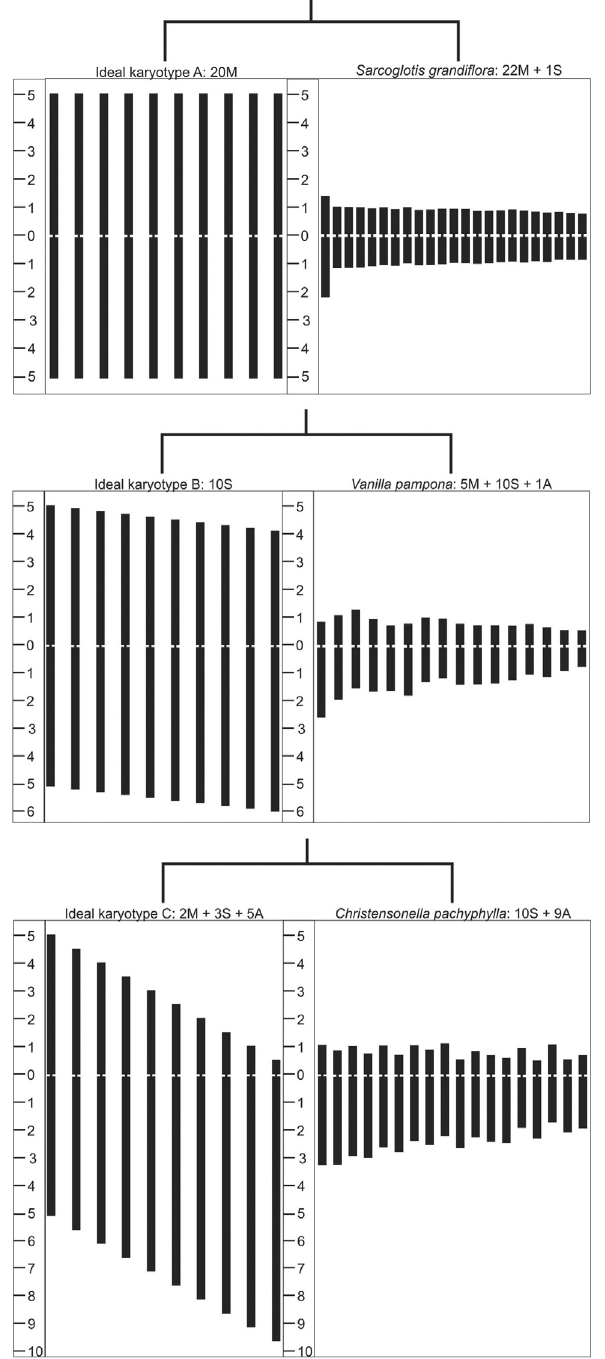
Figure 2 - Ideograms of the ideal karyotypes A, B and C, as well as the most similar species, grouped by UPGMA, equally obtained by the in- dexesAsk%,A1,SyiandA.Thenumericscaleattherightsideoftheideo- gram is given in micrometers ( (cid:3) m).